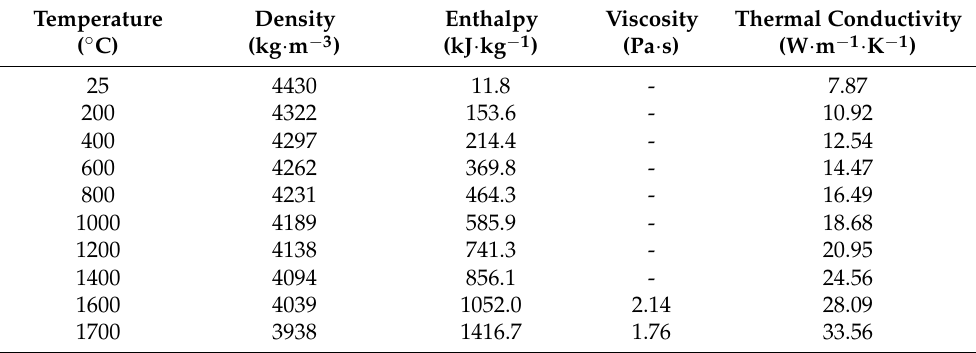
Table 1. Physical parameters of Ti-6Al-4V based on ProCAST